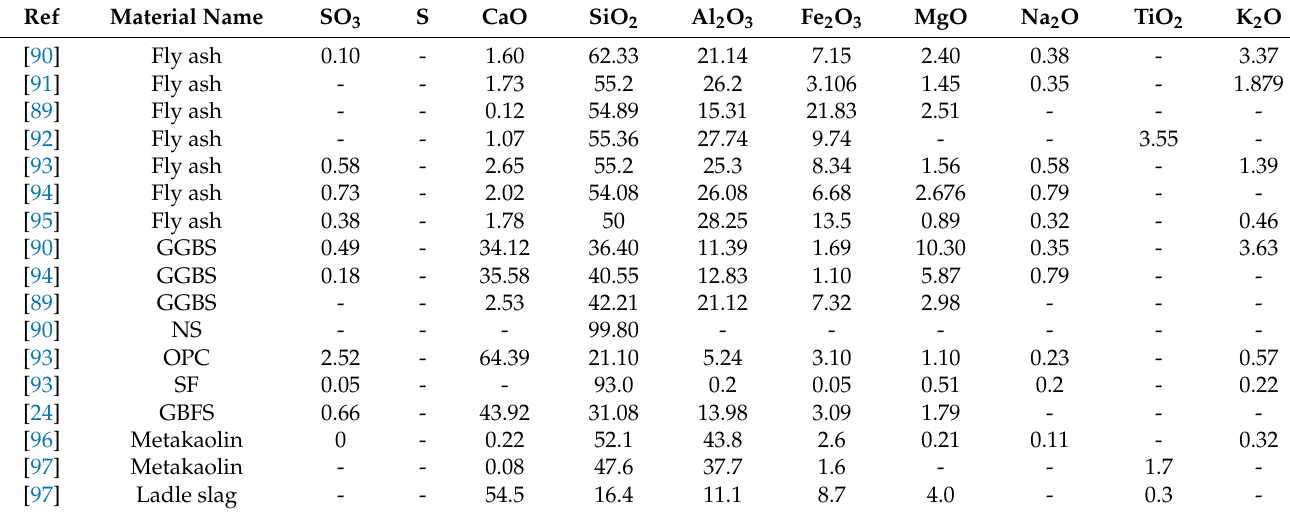
Table 1. Chemical properties of various